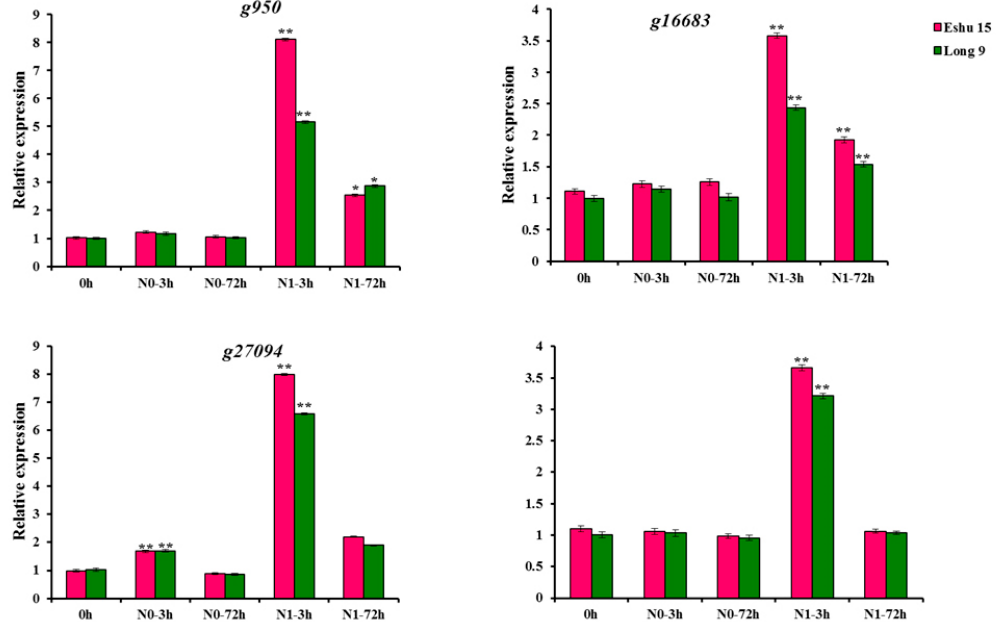
Figure 6. Expression analysis of g950 , g16683 , g27094 and g33987 of Eshu 15 and Long 9. The significance of differential gene expression levels compared with control are denoted as * < 0.05, ** < 0.01.